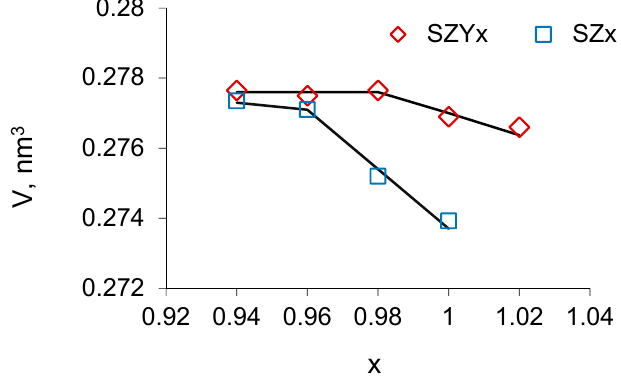
Figure 2. Unit cell volume as a function of Sr content in SZx and SZYx.